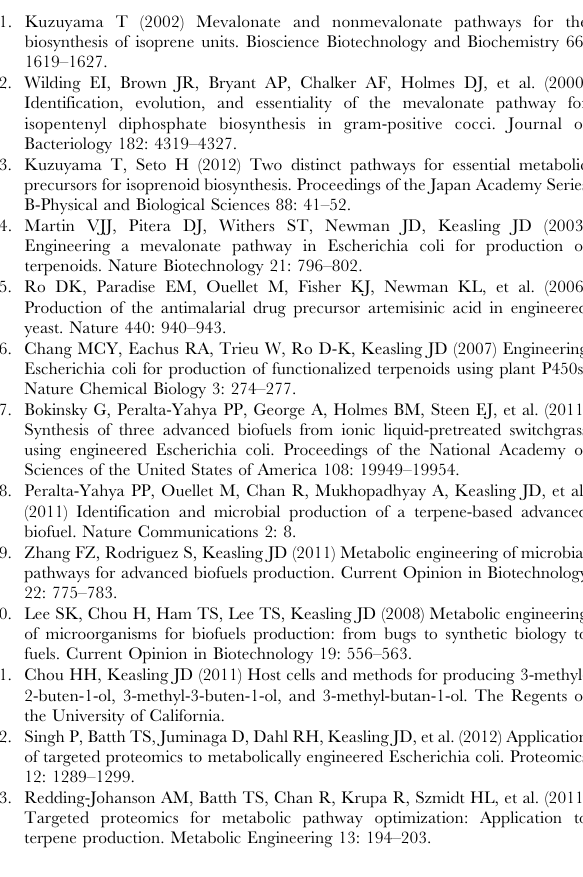
Figure S1 Sequences of the original PMK and the codon- optimized version of